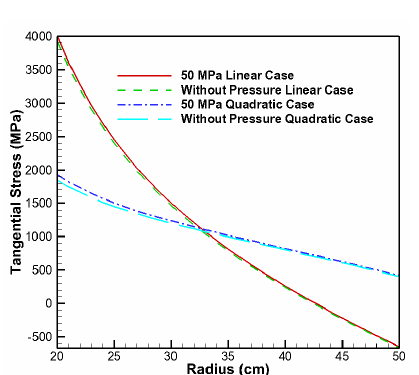
Figure 10. Displacement: q = r i T = 0 o C , T ref